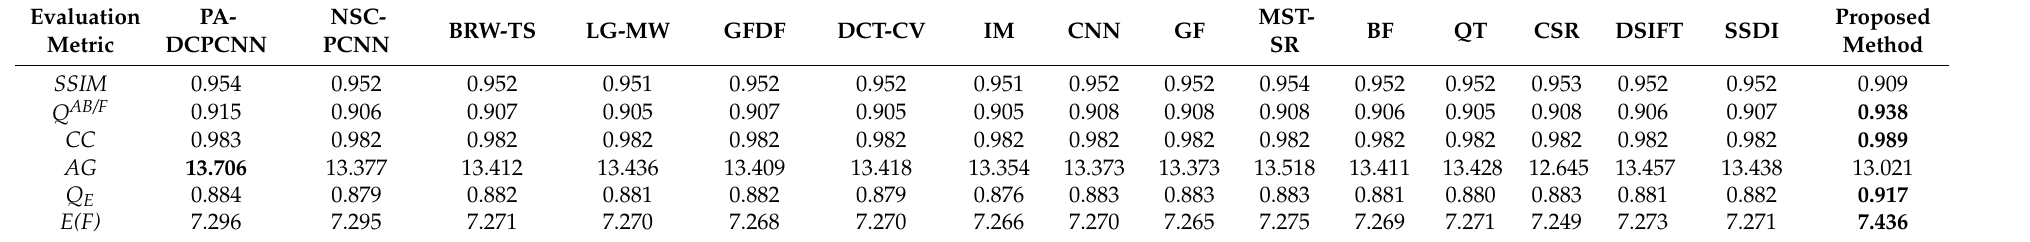
Figure 11. (Book): ( a ) original Image; ( b , c ) multi-focus input images; and ( d ) proposed fusion. Table 16. The outcomes for the book image and comparisons with existing techniques in the literature ([21]).